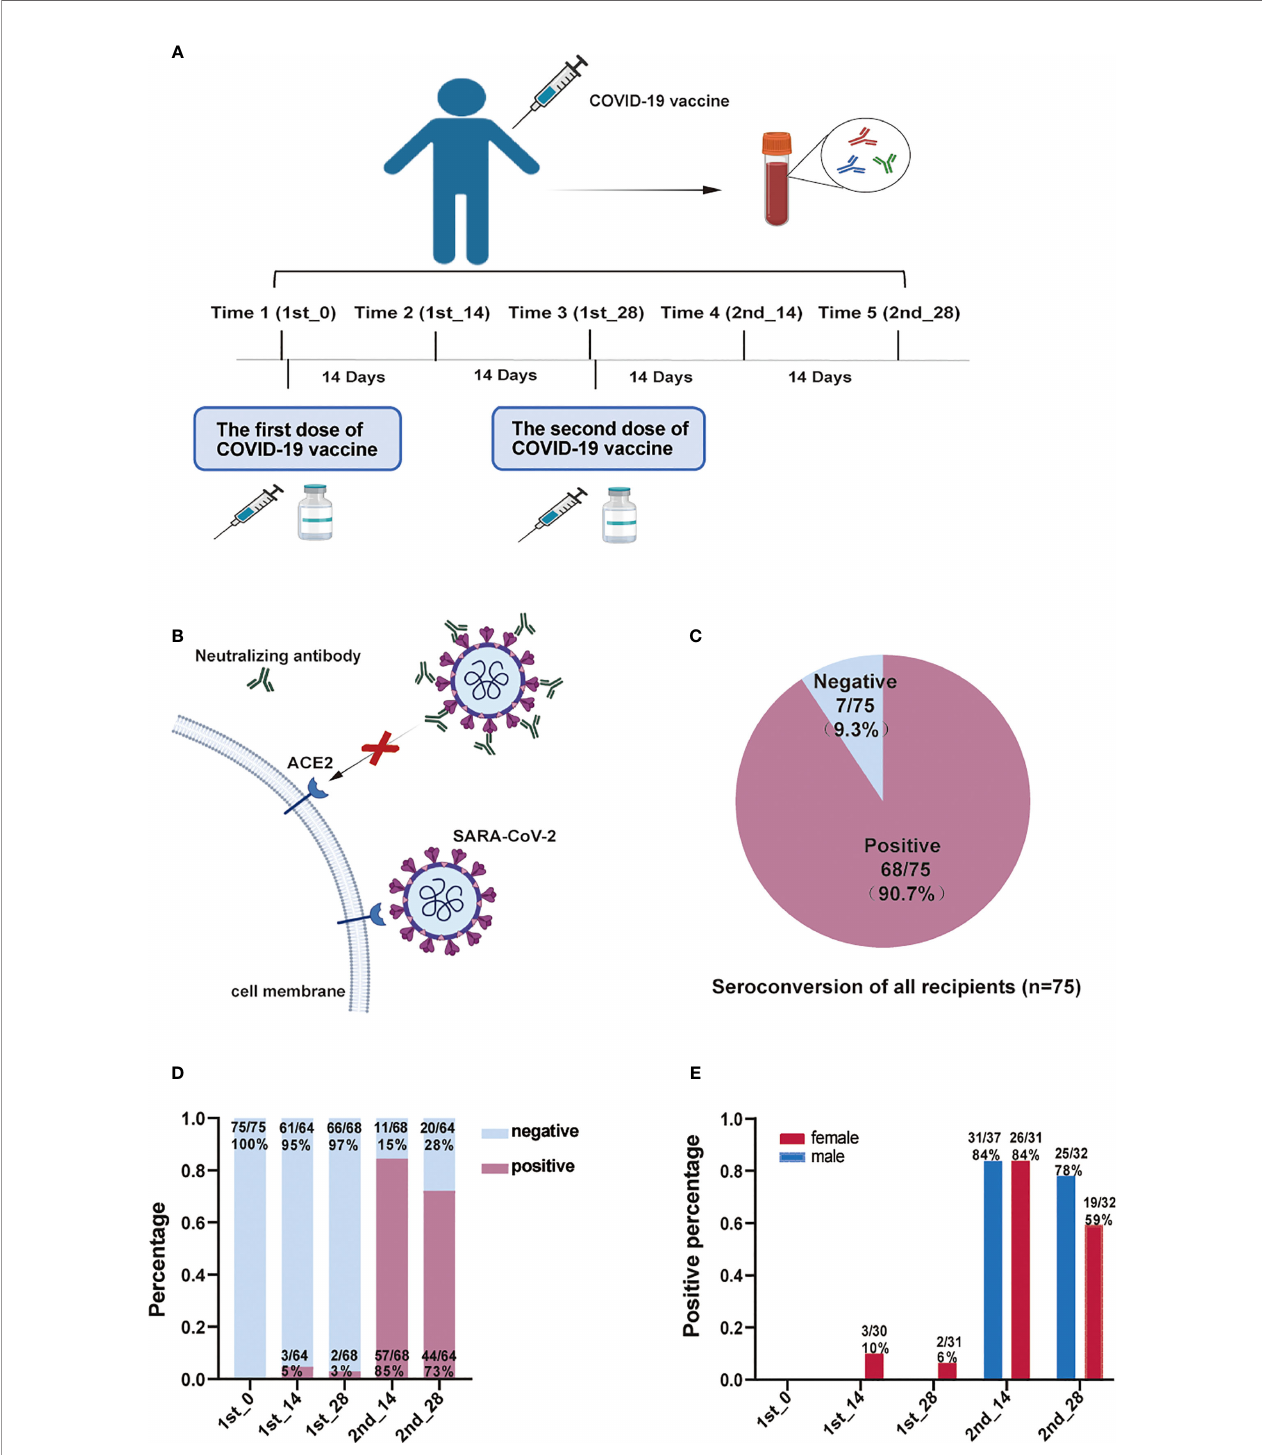
FIGURE 1 | Experimental study scheme and anti-SARS-CoV-2 neutralizing antibody detection. (A) The experimental scheme of this study. (B) The mechanism of the micro-neutralization test. Anti-SARS-CoV-2 neutralizing antibodies bind to the virus and prevent it from recognizing the ACE2 receptor. (C) NAb seroconversion rates of all recipients (n=75). (D) The proportion of NAb titer-positive recipients at different time points after vaccination. (E) The proportion of NAb titer-positive males and females at different time points after vaccination. COVID-19, Coronavirus Disease 2019; ACE2, angiotensin-converting enzyme 2; NAb, anti-SARS-CoV-2 neutralizing